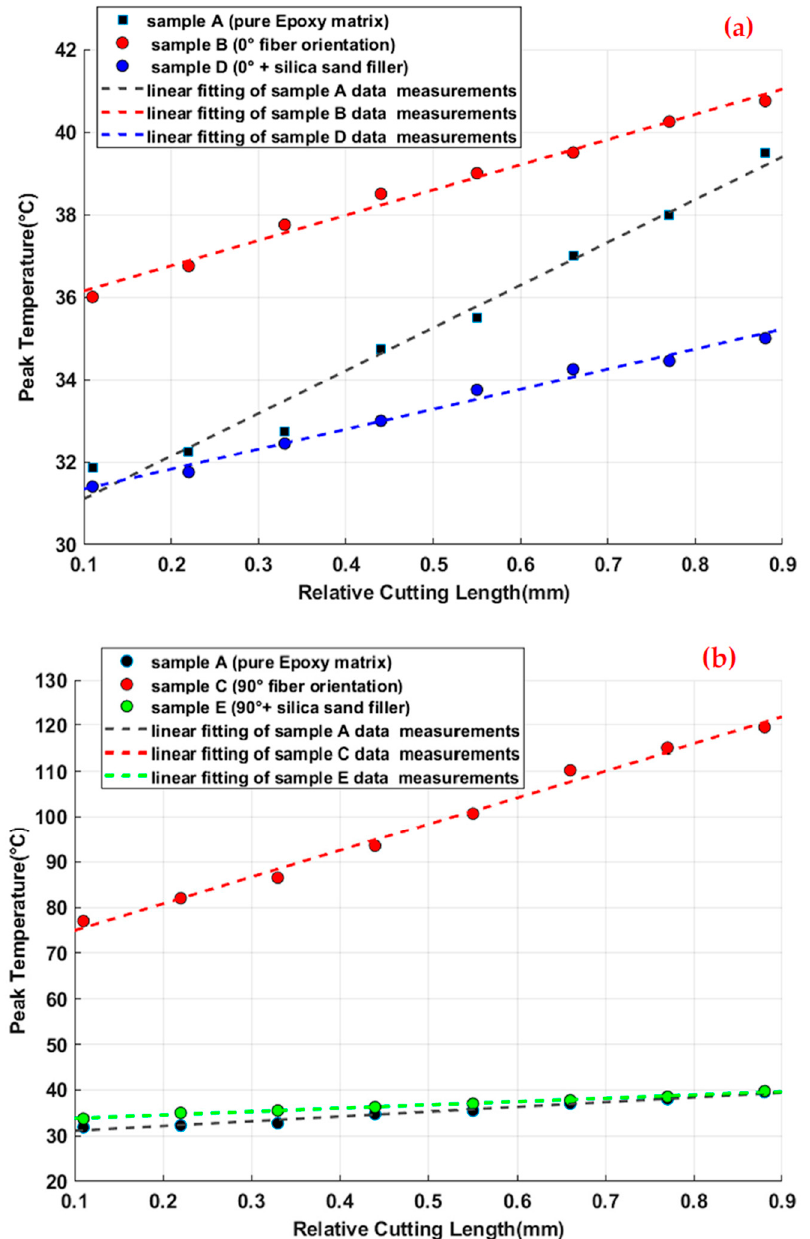
Figure 5. Peak Temperature over relative cutting length: ( a ) 0 ◦ fiber orientation samples vs. pure epoxy sample ( b ) 90 ◦ fiber orientation specimens vs. pure epoxy specimen. Table 6. Summary of heating rate measurements and correspondent R-square values.